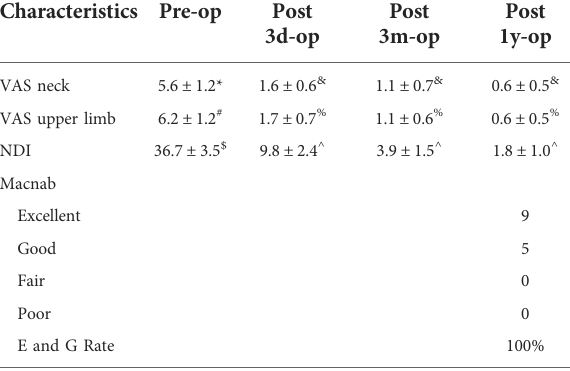
TABLE 3 Comparation of the functional score between pre and postoperative. Characteristics Pre-op